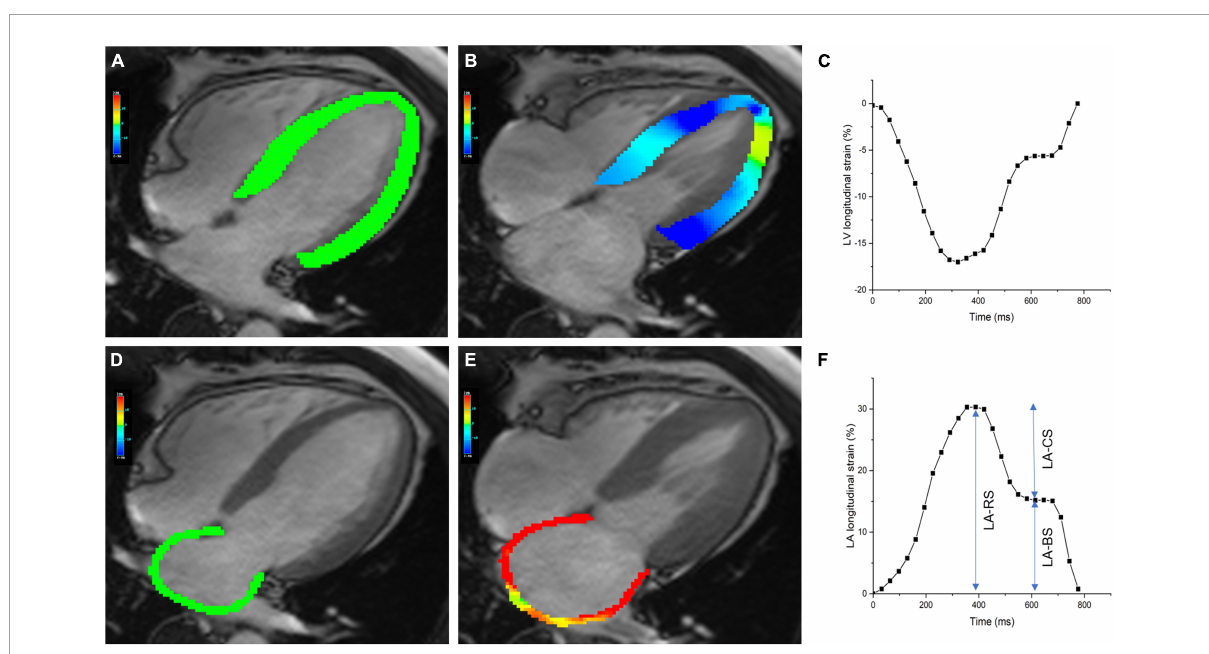
FIGURE1 Cardiac magnetic resonance (CMR)-derived left ventricular and atrial longitudinal strain. Panels (A,B) show the pseudocolor maps of LV longitudinal strain in the four-chamber view at the end-diastolic and end-systolic phases. Panel (C) shows representative plot of LV longitudinal strain. Panels (D,E) show the pseudocolor maps of LA longitudinal strain in the four-chamber view at the end-diastolic and end-systolic phases. Panel (F) shows a plot of LA longitudinal strain, along with measures of reservoir, conduit, and booster strain. LA-RS, LA reservoir strain; LA-CS, LA conduit strain; LA-BS, LA booster strain.